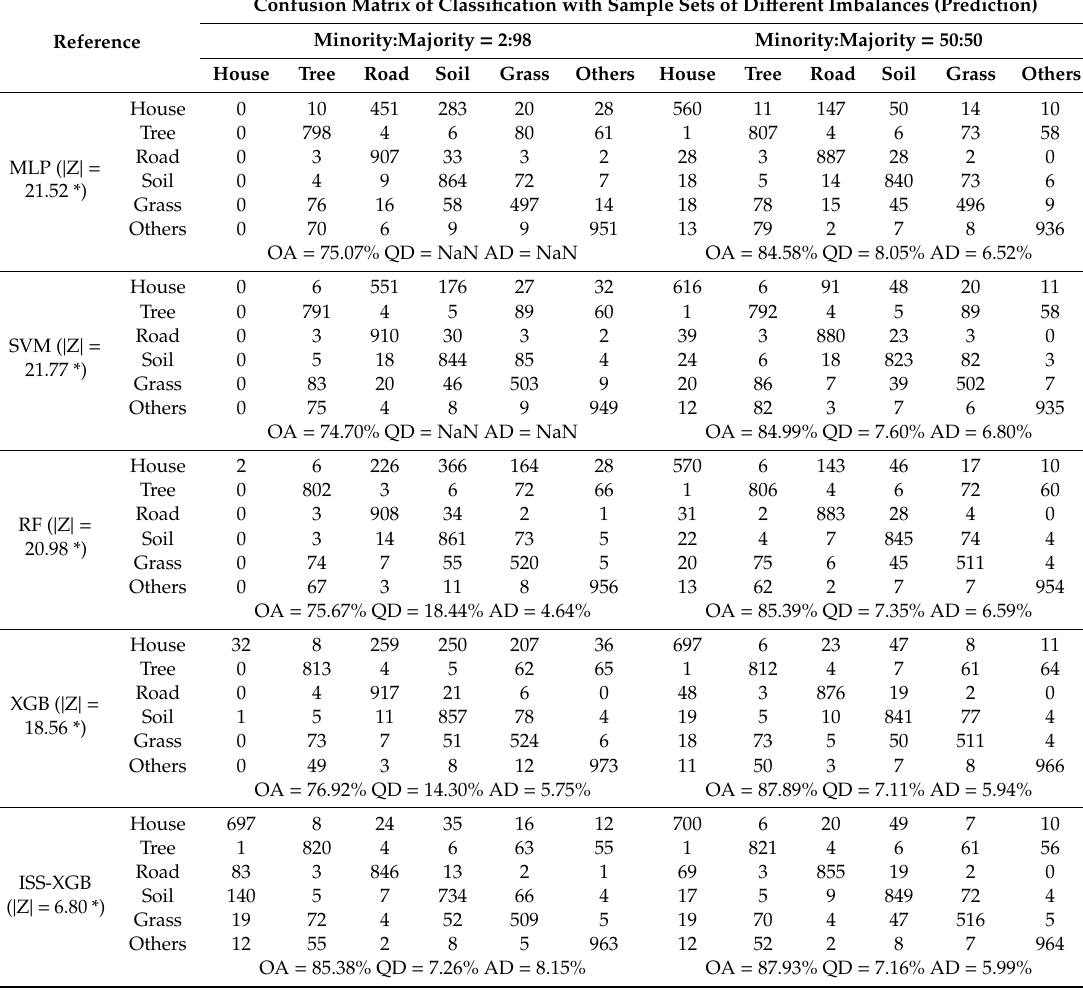
Table 4. Confusion matrix of Area 6 for one trial of 5